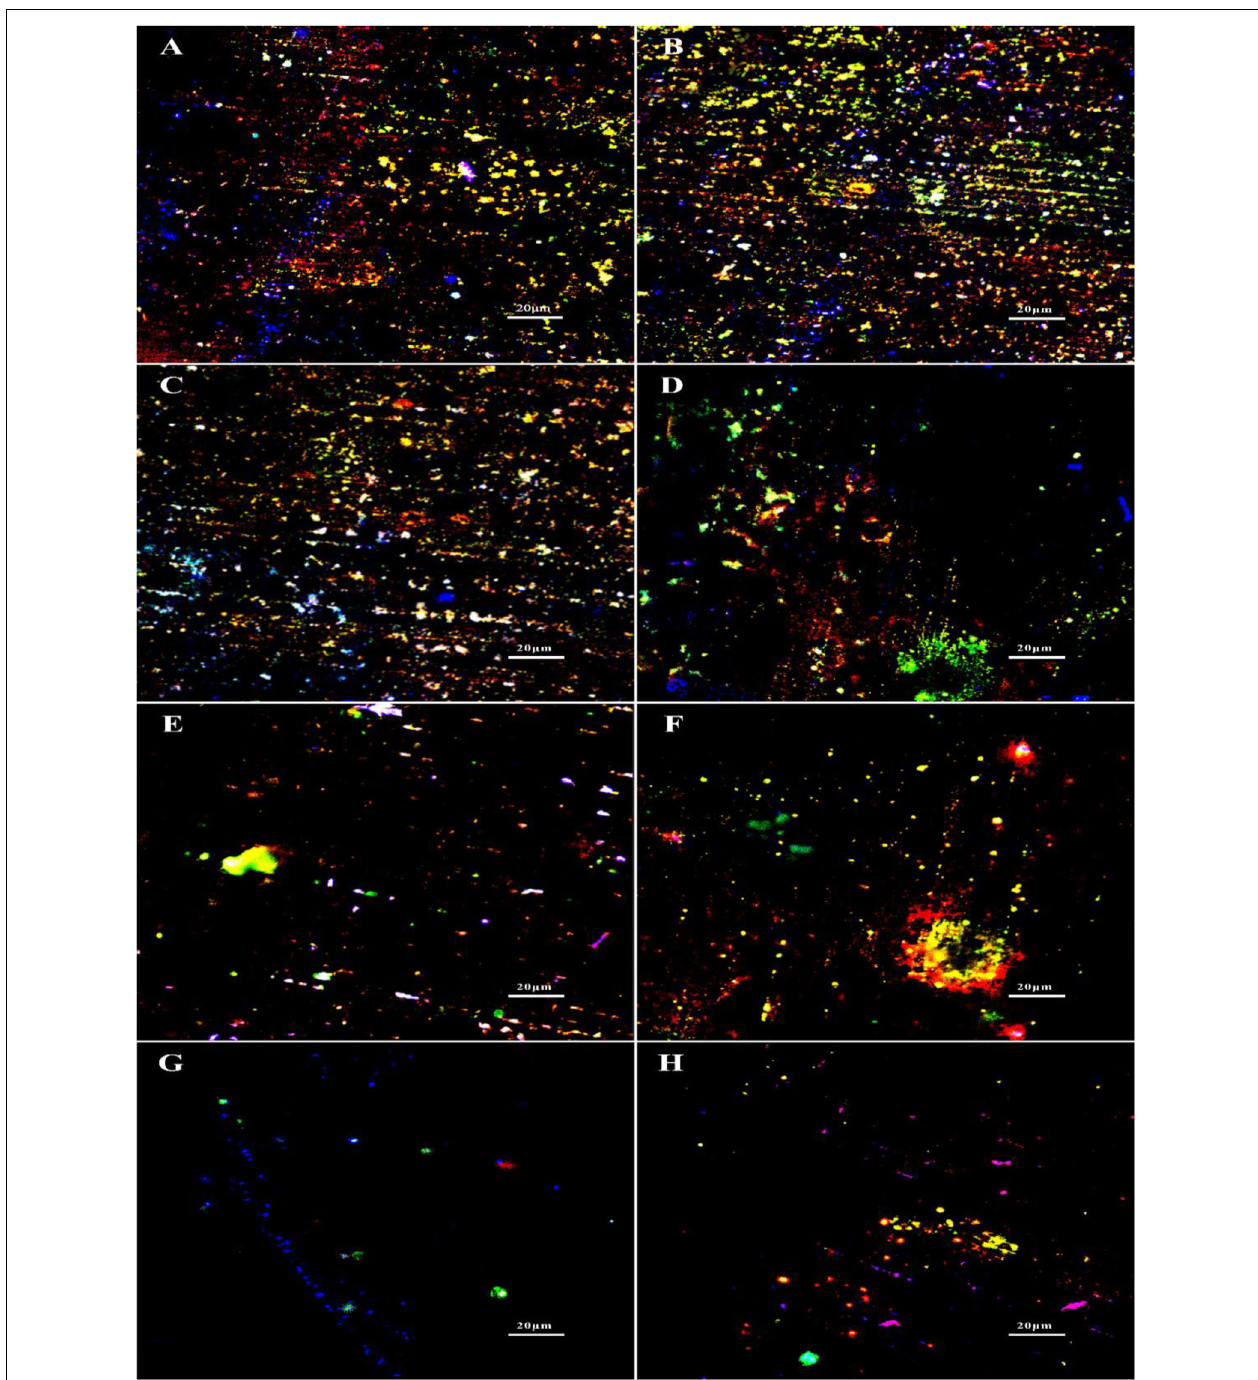
FIGURE 6 | EPS staining after biofilm prevention test: (A) no treatment (control), (B) 1 ppm D -Tyr, (C) 100 ppm D -Met, (D) 5 ppm CMIT/MIT, (E) 5 ppm CMIT/MIT + 1 ppm D -Tyr, (F) 5 ppm CMIT + 100 ppm D -Met, (G) 5 ppm CMIT/MIT + 1 ppm D -Tyr + 100 ppm D -Met, and (H) 25 ppm CMIT/MIT. Blue, red and green dots represent extracellular DNAs, proteins, and polysaccharides,